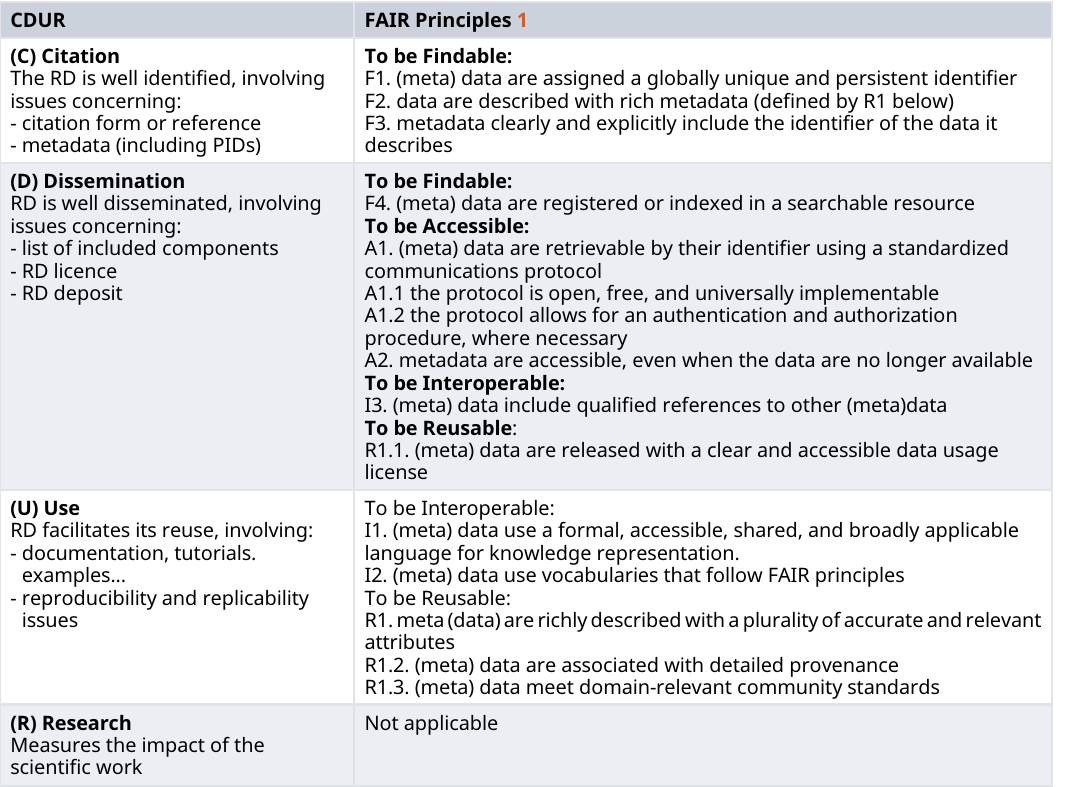
Table 1. This table illustrates the relationships between the FAIR principles and the CDUR RD evaluation protocol proposed in Section 3.3. CDUR FAIR Principles